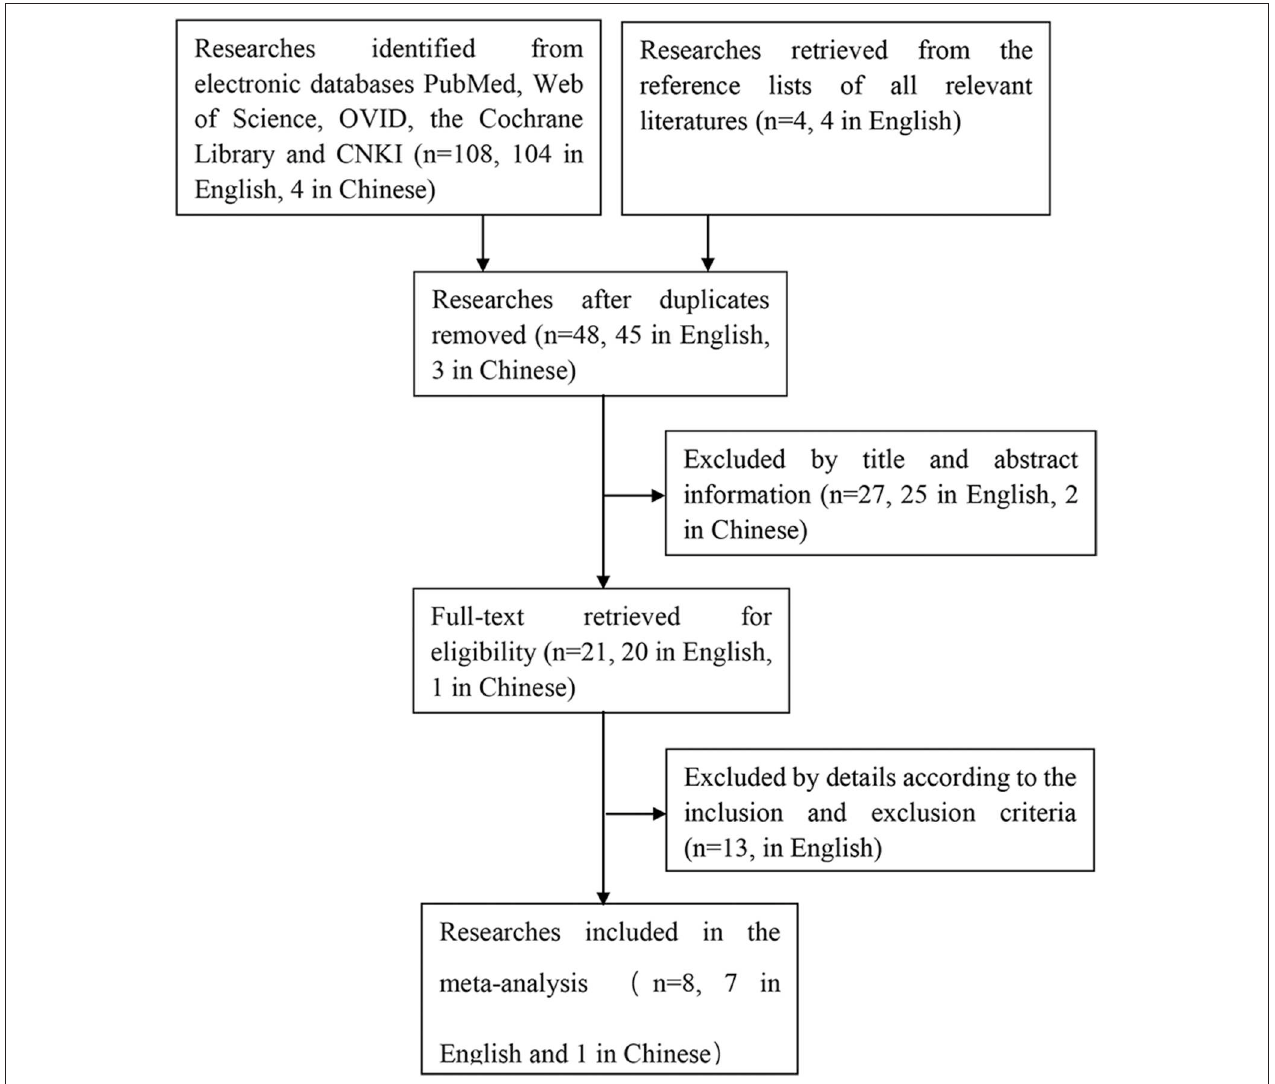
FIGURE 1 | Flow diagram of the study selection